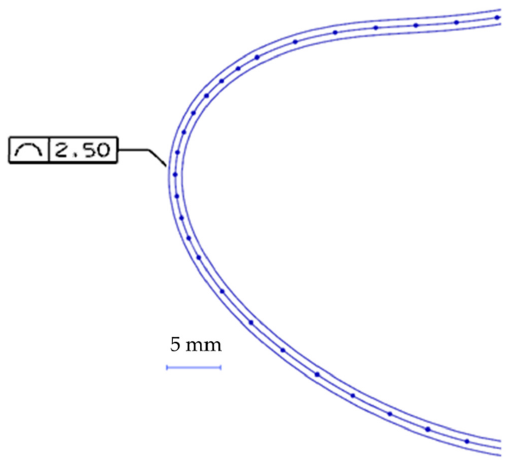
Figure 4. Ideal shape with knots with boundary of GD&T tolerance.